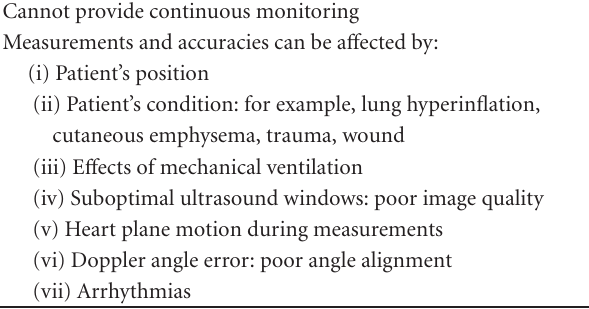
Table 2: Limitations of cardiac output measurements in ICU by